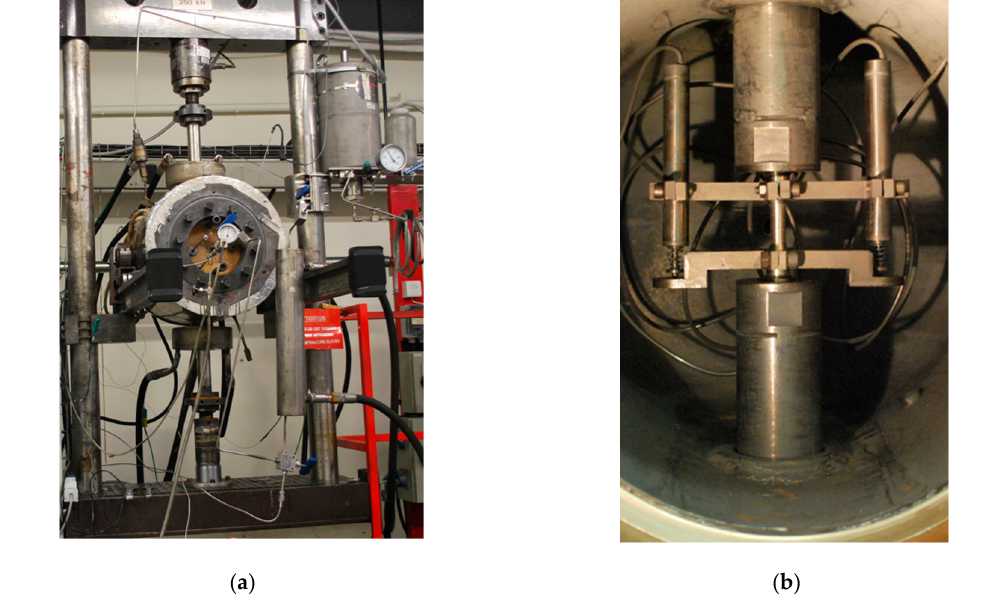
Figure 2. PWR test rig ( a ) general view of the autoclave and loadframe, and ( b ) close view of the specimen equipped with LVDT sensors for strain control.